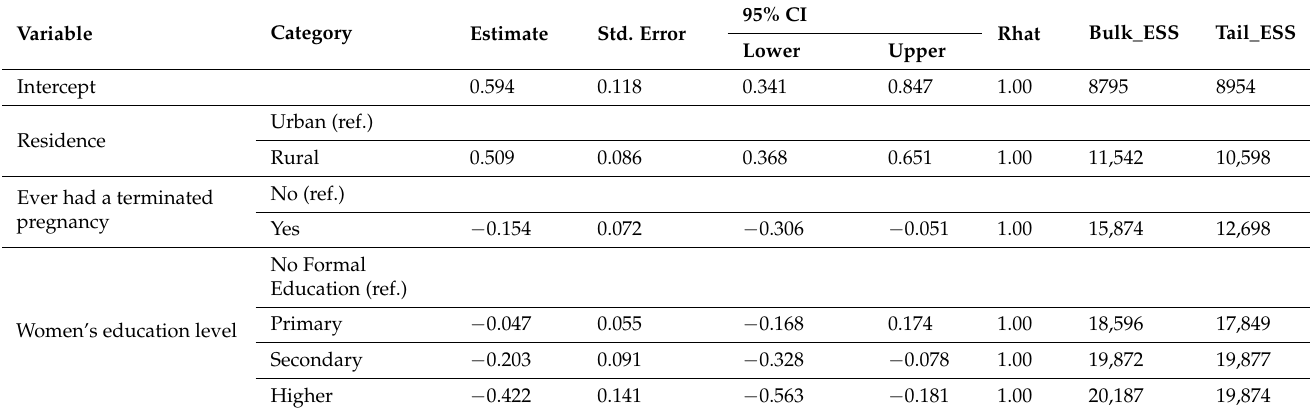
Table 4. Result of the Bayesian multilevel